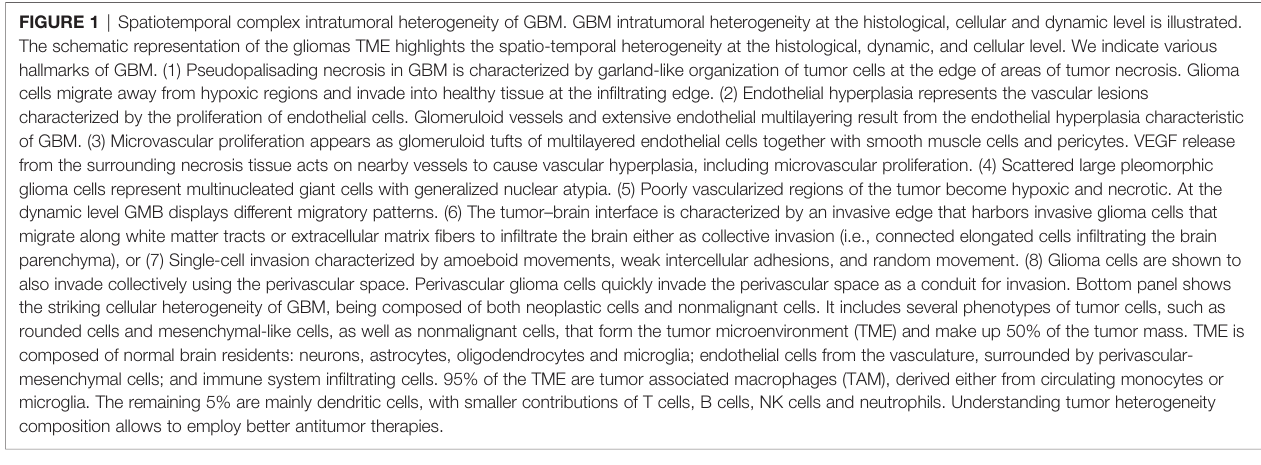
( Figure 1 ). Research studies using tumor sampling from different anatomical locations demonstrated that 60% (6/10) of tumors presented two or three different subtypes within the same tumor (68). Other studies showed that molecular subtypes correlate with histological features. Mesenchymal tumor was associated with hypoxic and perinecrotic areas and high microvascular proliferative zones, while Classical was related to vascular and invasive zones. Tumors with these two characteristics had the worst prognosis (69).